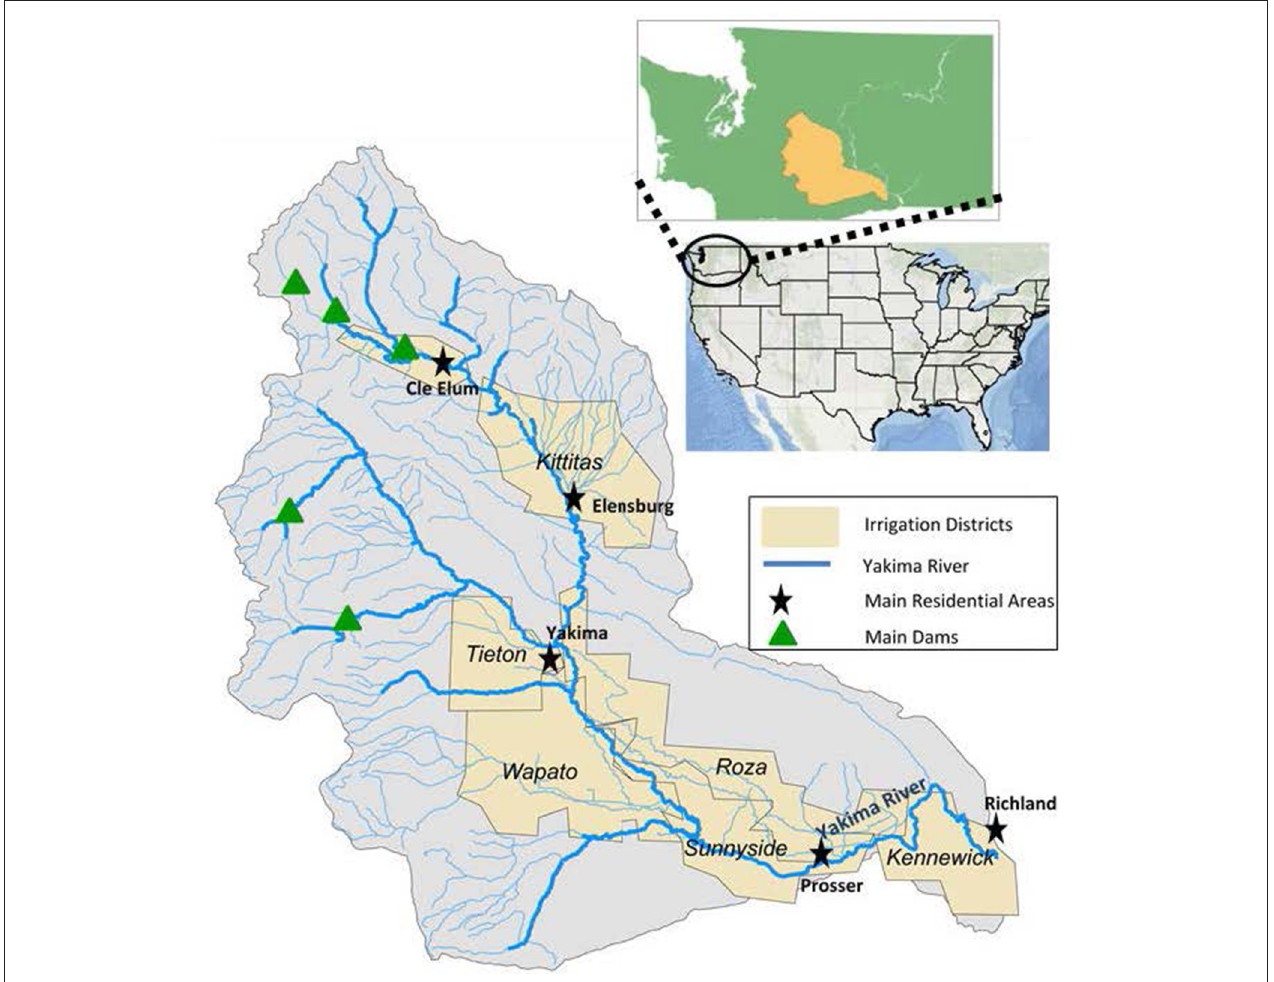
FIGURE 1 | Yakima River Basin in Washington State,